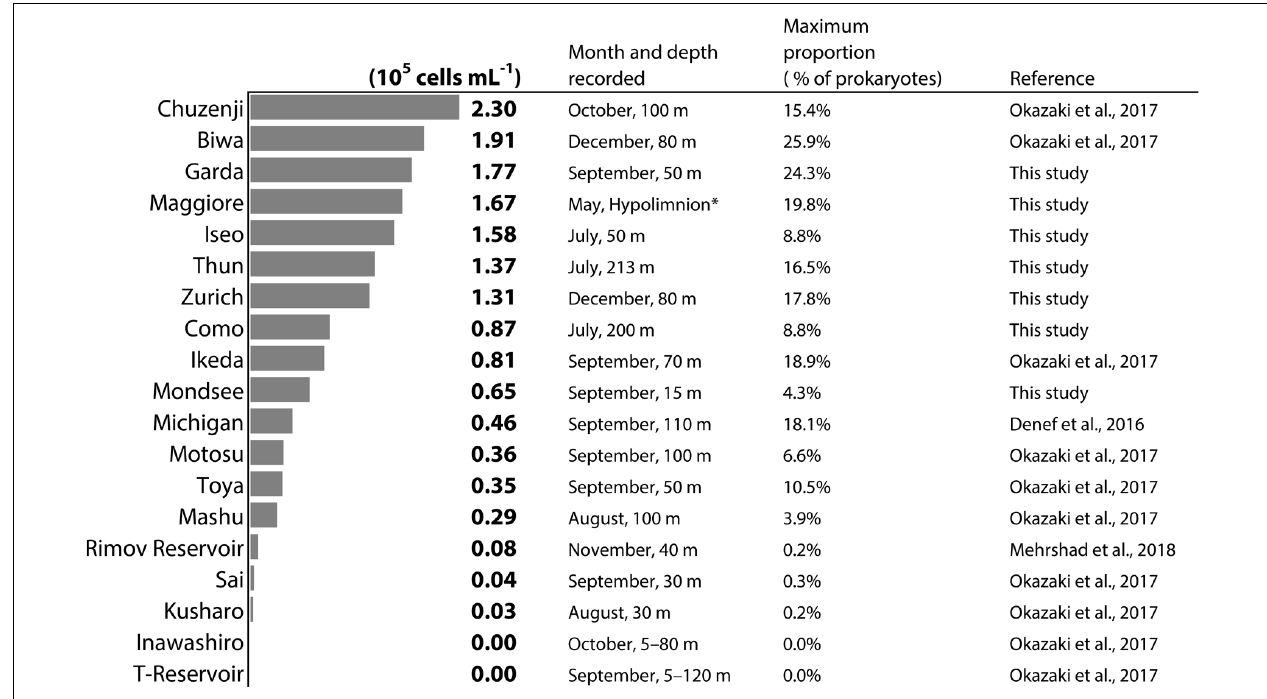
FIGURE 5 | Maximum abundance of CL500-11 recorded by CARD-FISH analyses in each lake. ∗ Bacterial abundance in the hypolimnion of Lake Maggiore was determined using an integrated sample from 20 to 350 m. TABLE 2 | The Spearman’s coefficients ( ρ ) and the corresponding p -values between the CL500-11 maximum abundance and environmental measurements in each lake. pH pH TN TN TP TP Surface Surface Water Maximum Water Hypolimnetic (min) (max) (min) (max) (min) ∗ area elevation retention depth volume temperature time during stratification